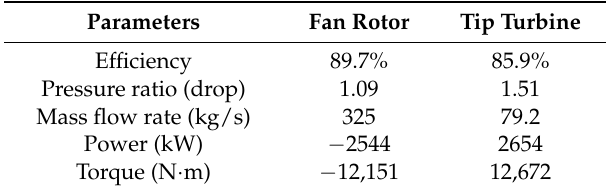
Table 2. CFD Results of the air-driven fan and tip